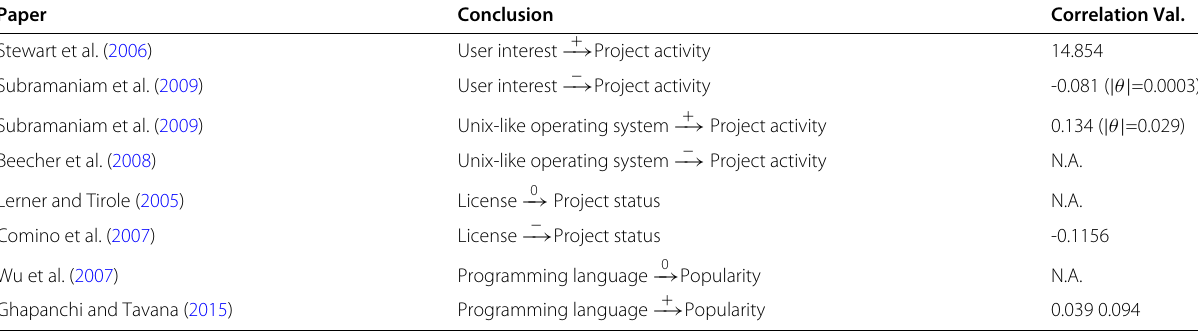
Table 9 The indicators have been analyzed and whose conclusions are inconsistent. “ A − −→ “ A B ” indicates A has negative influence on B , and “ A 0 −→ B ” presents A and B are independent. θ is the threshold for correlation. Generally, a value larger than | θ | indicates a considerable positive or negative effect between two